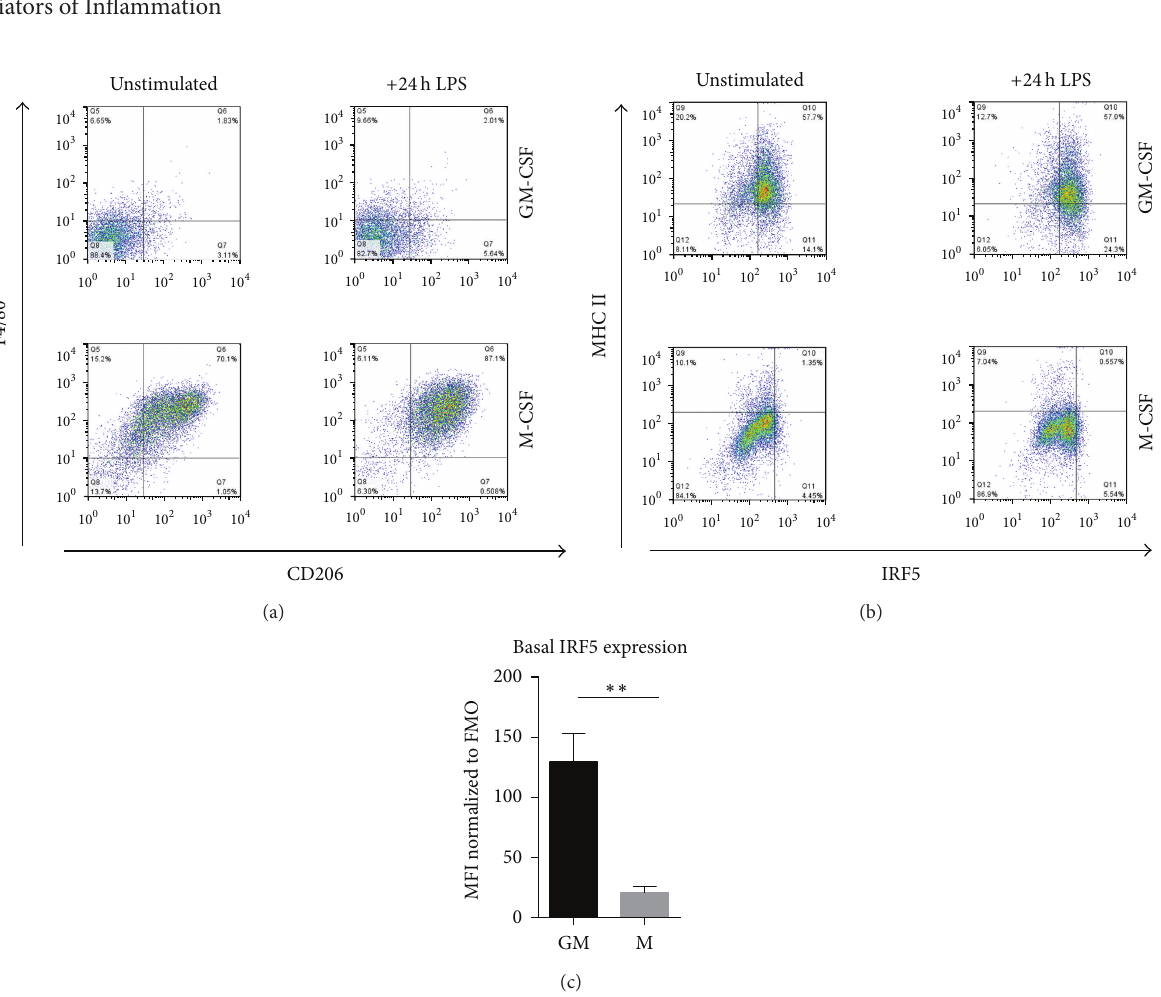
Figure 2: Surface receptor expression of polarised macrophages and intracellular IRF5 staining. Macrophages were in vitro differentiated with GM-CSF or M-CSF for eight days and then stimulated with LPS for 24 h. FACS samples were collected before and after stimulation. (a) and (b) Samples were stained for the expression of F4/80, CD206, MHC II, and IRF5. (c) Macrophages were stained for intracellular IRF5 and staining in unstimulated cells was quantified by mean fluorescence intensity (MFI). Error bars represent the standard error for 𝑛 = 6 . Statistical analysis was performed by one-tailed Mann-Whitney 𝑈 test. ∗∗ 𝑃 ≤ 0.01